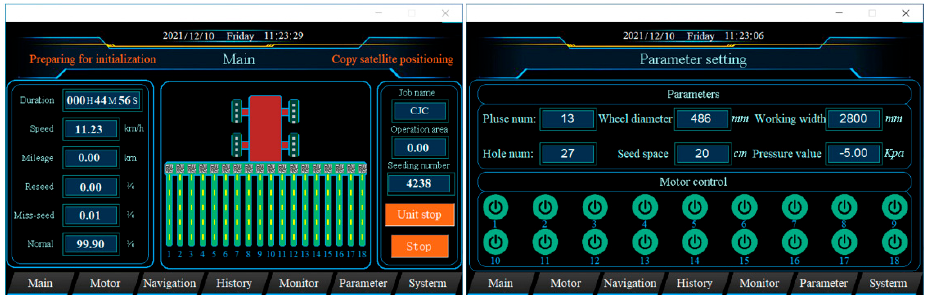
Figure 3. Partial human–computer interaction software interface.